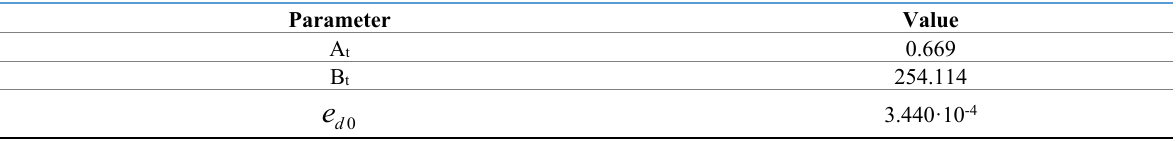
Table 3. Mazars’ [2] parameters.